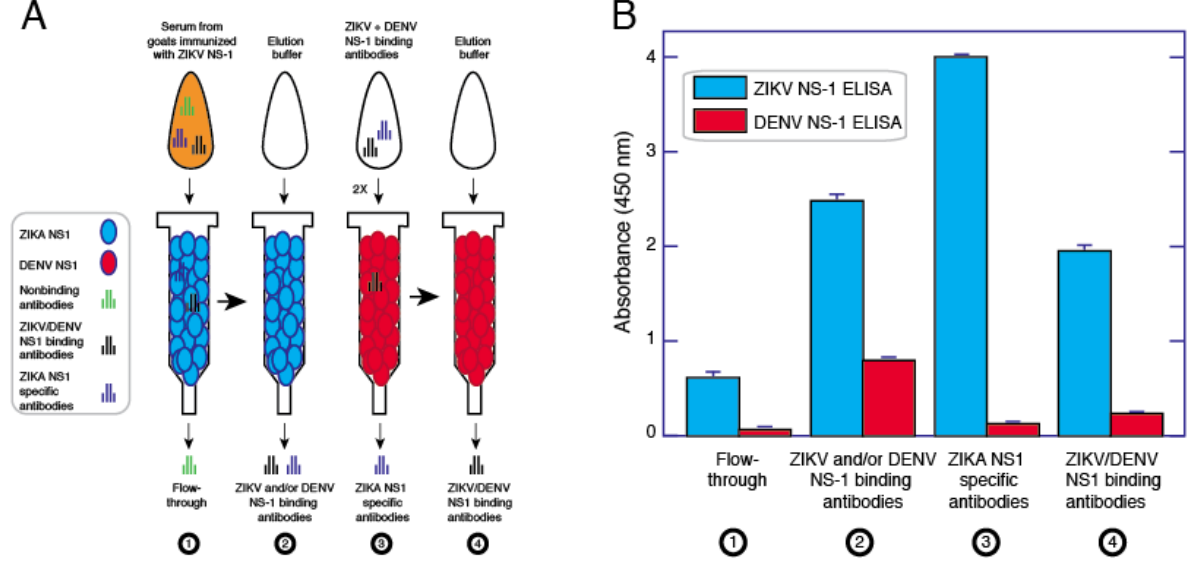
Figure 5. Process for purifying and cross-adsorbing ZIKV NS1 antibodies. ZIKV NS1 antibodies were affinity purified using a gravity flow column. ( A ): The bound and eluted fraction was put through a column with DENV NS1 twice. The unbound and eluted (non-DENV reactive) fraction is the cross-adsorbed, ZIKV-specific fraction. ( B ): Antibodies flowing through the column initially bind ZIKV at low signal strength. Following ZIKV NS1 column elution, strength of binding of the solution goes up, but DENV NS1 reactivity is present. Upon cross-adsorption against DENV NS1, specificity of the pAb solution goes up, as well as its binding avidity to ZIKV NS1.